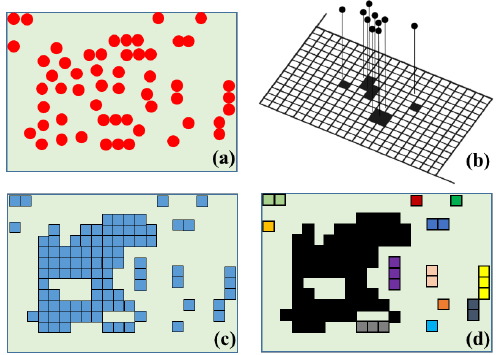
Figure 2. Conceptual illustration of the refinement process: ( a ) Inlier points of model plane; ( b ) Projection of points on plane; ( c ) Rasterized image; ( d ) Result of image labeling (gray-colored area is integrated into the largest black-colored area; the other colored areas, such as yellow, green, blue, etc. , are considered to be noise). (Figure is adopted from [15]).